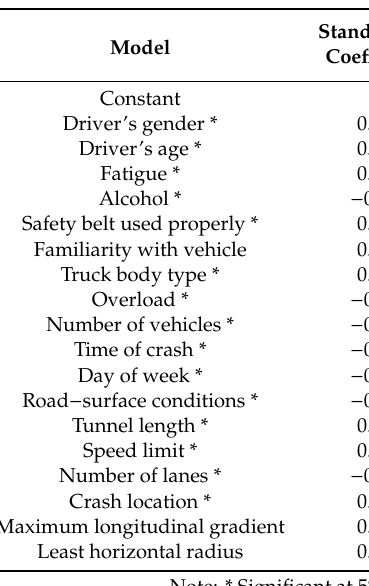
Table 3. Results of the Multicollinearity Test.